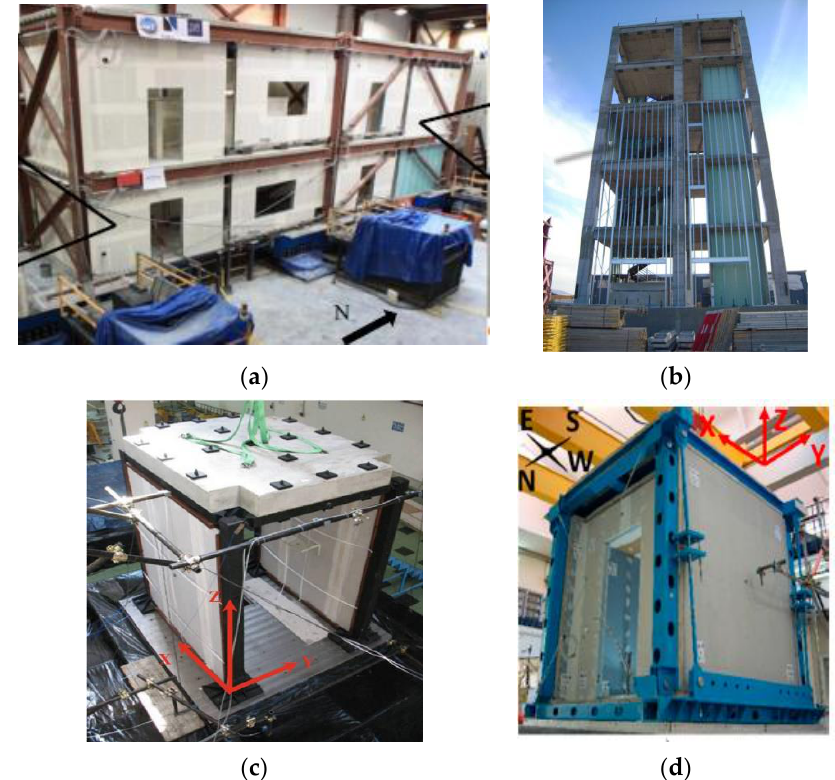
Figure 13. Shake-table tests conducted on the non-structural components: ( a ) two-storey steel braced building having partition walls and ceiling systems [63]; ( b ) five-storey reinforced concrete building equipped with partition and façade walls [59]; ( c ) single storey single-bay structure equipped with partition walls [60]; ( d ) single storey single-bay structure equipped with partition walls, facade walls, suspended ceilings, and their combinations [61].